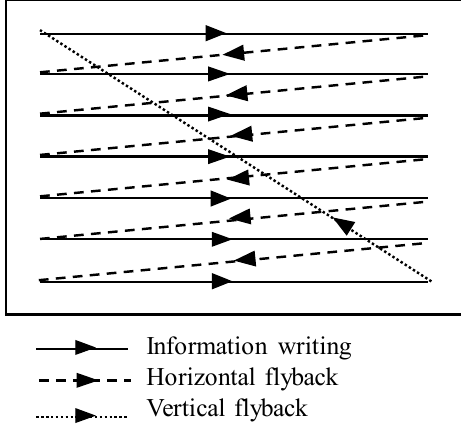
Figure 6. Sequential frame of the information writing on the monitor.